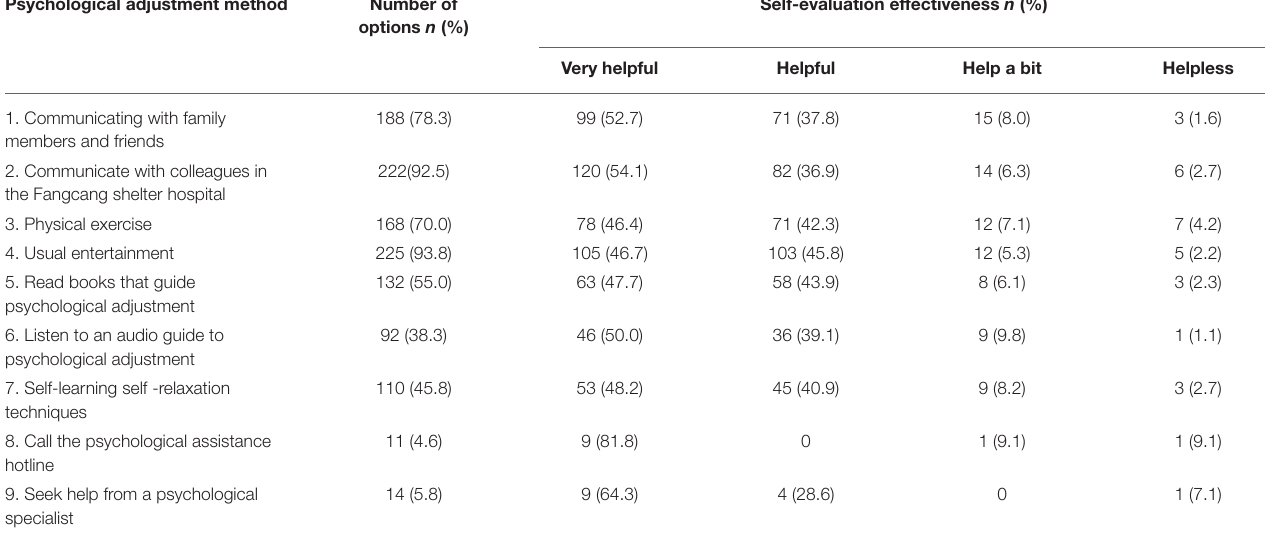
TABLE 4 | Psychological adjustment method and Self-evaluation effectiveness. Psychological adjustment